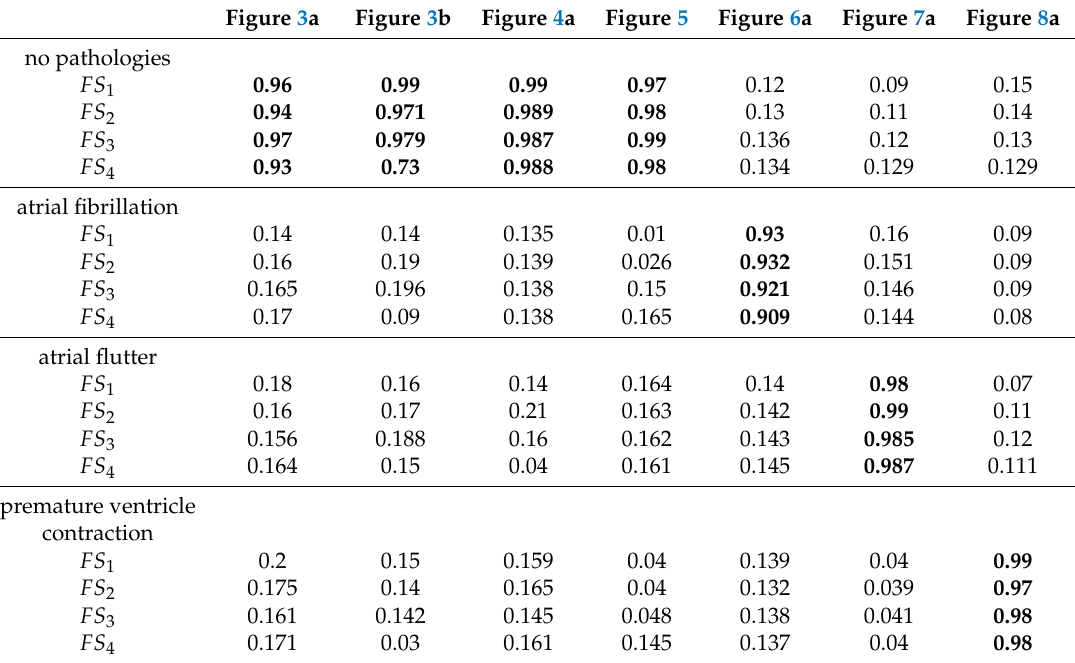
Table 4. FS 1 , FS 2 , FS 3 and FS 4 achieved for ECG s related to Case